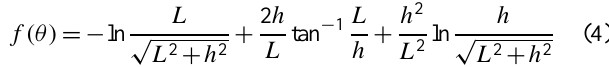
Fig. 7. Graphical illustration of relationship between θ , effective length ( L ), and lag distance ( h ).